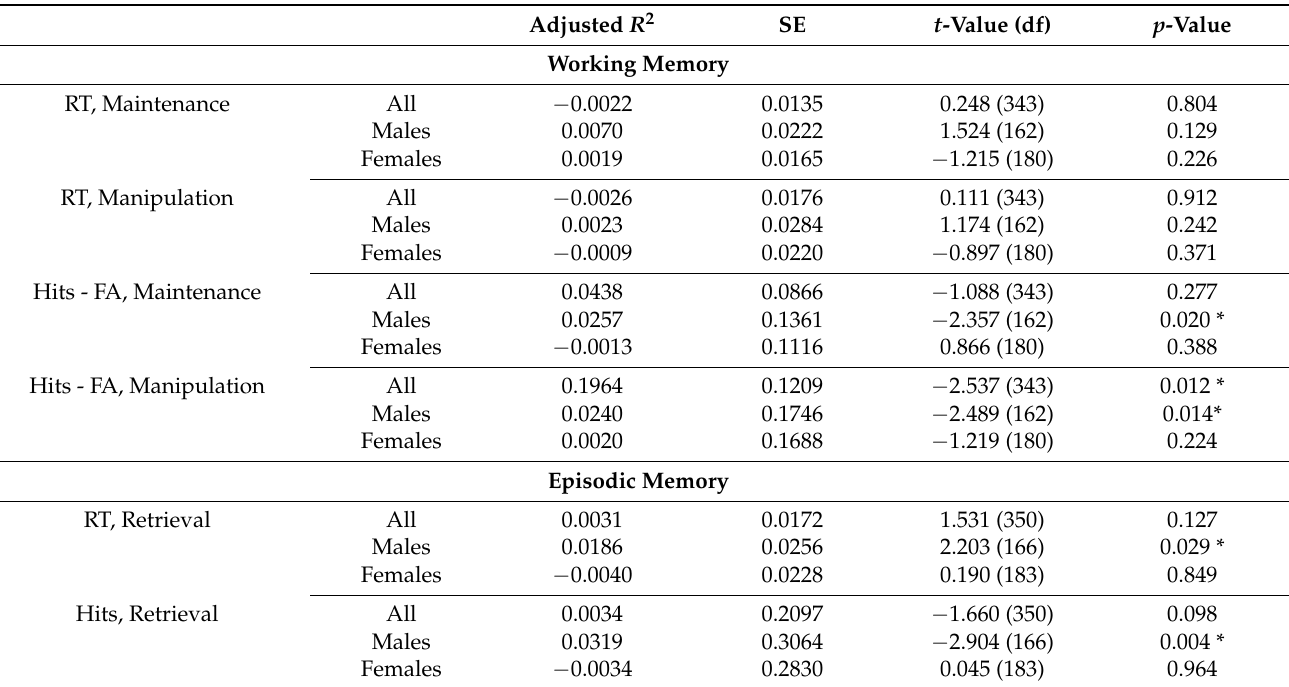
Table 2. Relationship between scanner task performance and polygenic risk for schizophrenia at